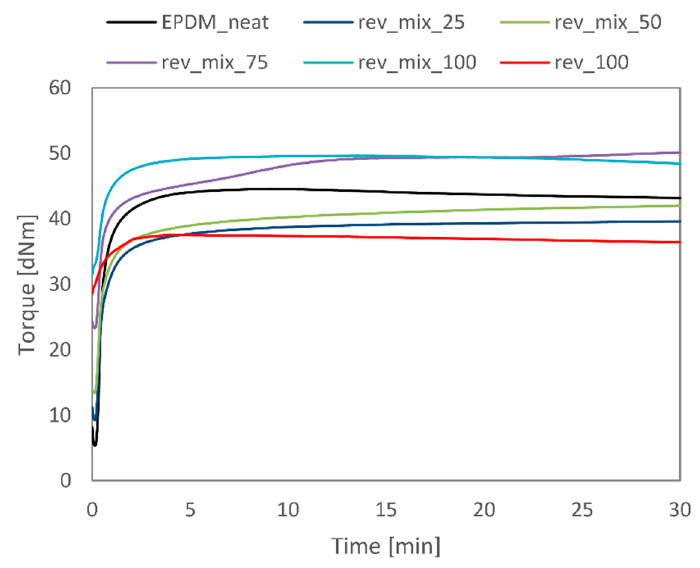
Figure 3. Curing curves for the EPDM revulcanisates.